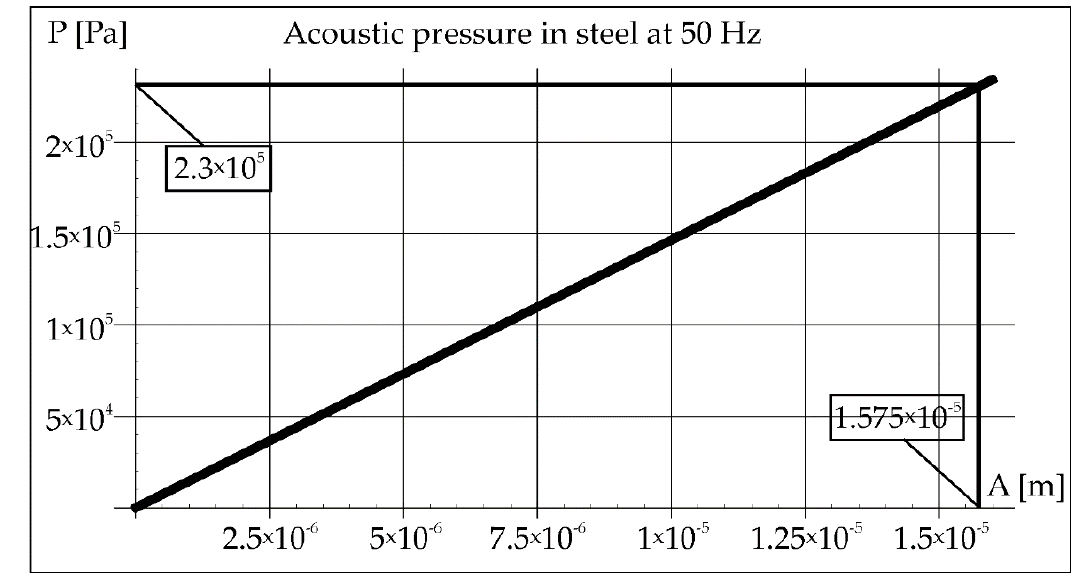
Figure 3. Acoustic pressure in steel at frequency 50 Hz.